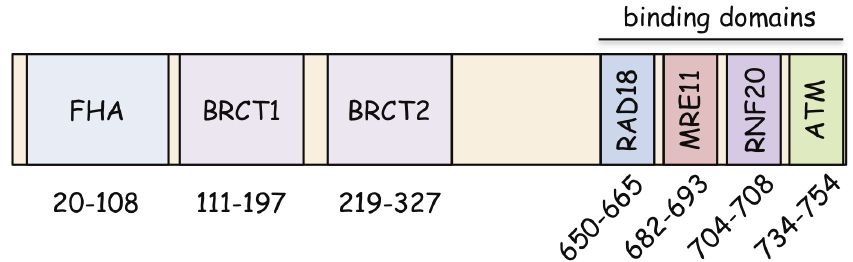
Figure 1. The structure of human NBS1. NBS1 contains several interaction domains in the N- and